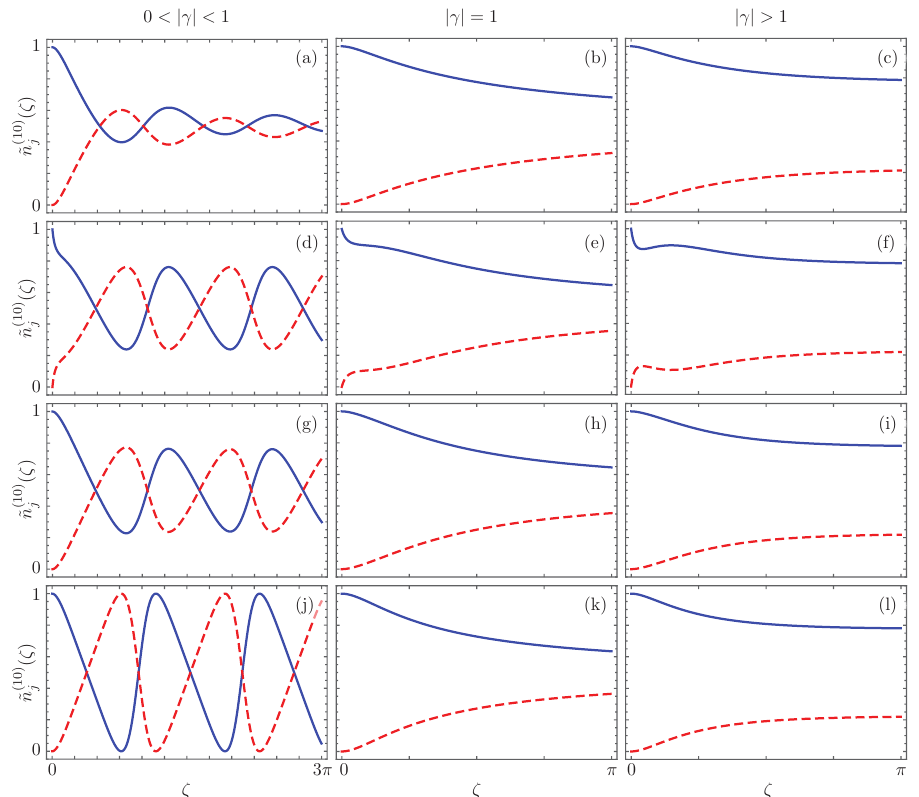
( ζ ) , along different realizations Figure 4. Instantaneously renormalized mean photon number, ˜ n ( 10 ) j of the effective -symmetric dimer. The first row, ( a – c ), shows balanced gain-loss, the second row, PT ( d – f ), shows gain-gain, the third row, ( g – i ), shows gain-passive, and the fourth row, ( j – l ), shows both = 0.5, γ passive-loss and loss-loss configurations in the -symmetric regime, the first column with PT | | = 1, the second column, and the broken symmetry regime, and the third γ the Kato point with | | = 1.2. Values for the first and second waveguides are shown with a solid blue and γ column with | | a dashed red lines, in that